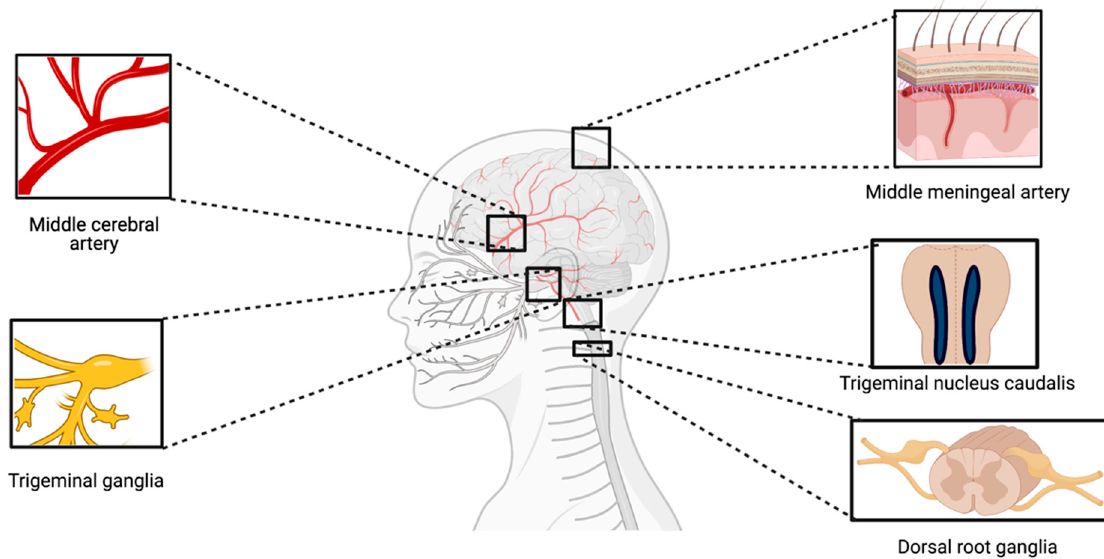
Figure 5. Distribution of BK Ca channels in the trigeminovascular system.